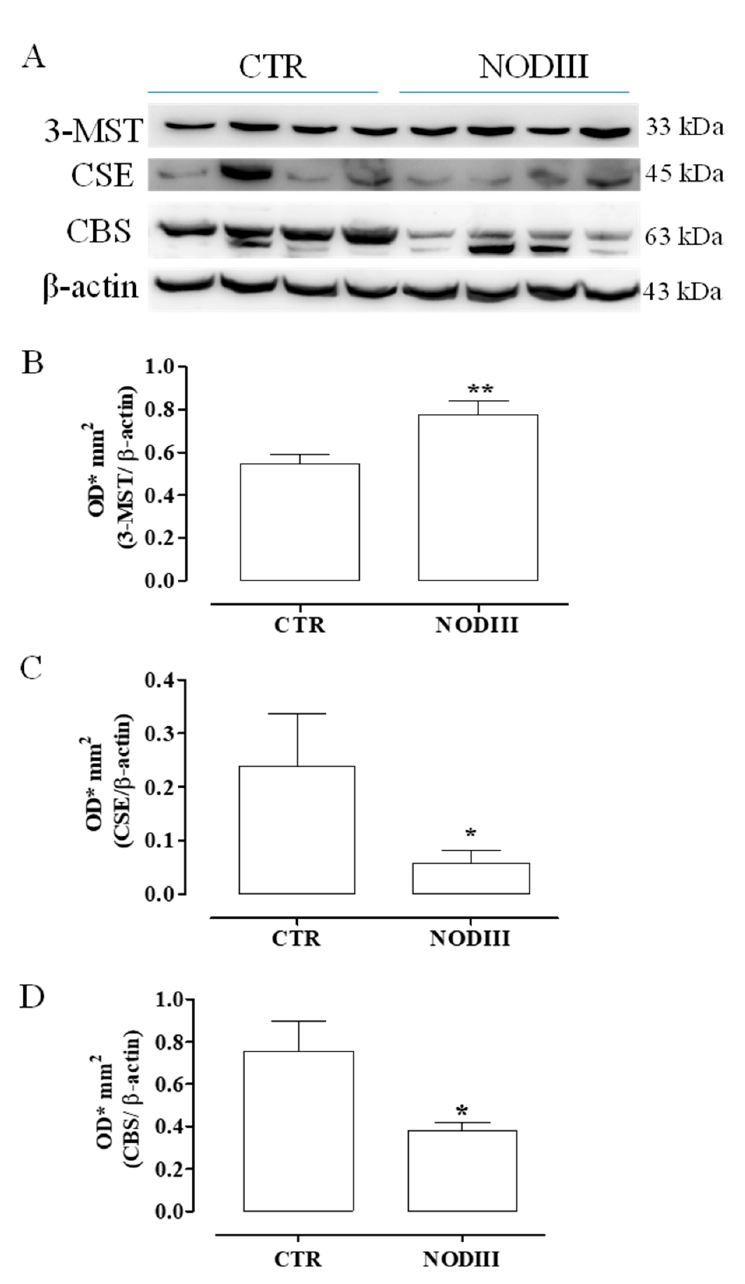
Figure 6. Expression of 3-MST, CSE, and CBS in uteri of CTR and NODIII mice. Representative western blot for 3-MST, CBS, and CSE ( A ). Expression of 3-MST is significantly higher in NODIII mice uteri vs. CTR mice ( B ) (** p < 0.01). CSE expression is significantly reduced in NODIII mice vs. CTR mice ( C ) (* p < 0.05). CBS expression is significantly reduced in NODIII mice vs. CTR mice ( D ) (* p < 0.05). Results are normalized against β -actin as housekeeping protein and calculated as mean ± SEM ( n = 8 mice). Data were calculated as OD*mm2 as optical density (OD)*mm2. Results are analyzed by unpaired Student’s t